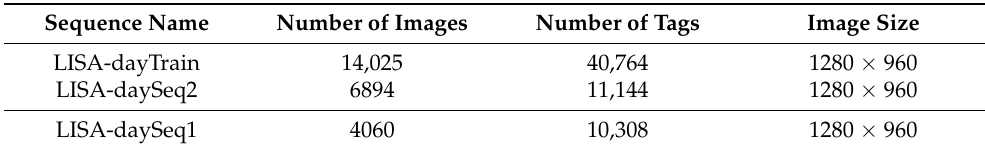
Table 3. Overview of the LISA traffic light data set.